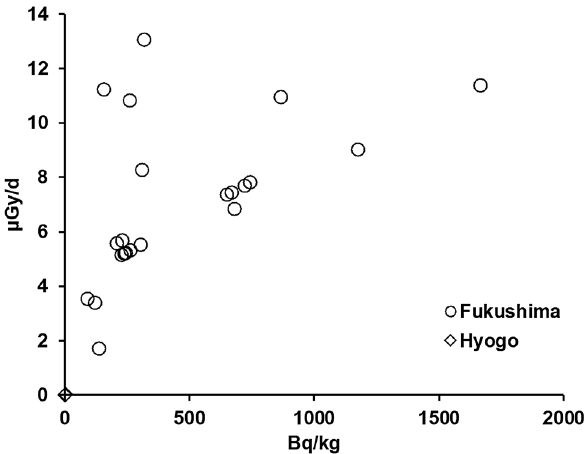
Figure 2. Relation between total exposure dose rate of whole body and 137 Cs radioactivity concentration in the skeletal muscles of wild boars in Hyogo ( n = 3) and Fukushima ( n = 22).